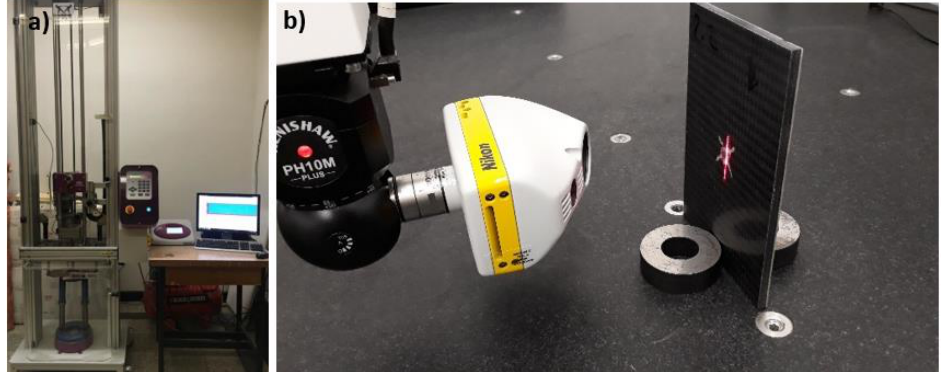
Figure 1. ( a ) INSTRON CEAST 9340 drop-tower impact testing machine; ( b ) Altera coordinate meas- uring machine equipped with LC15Dx CMM automatic laser